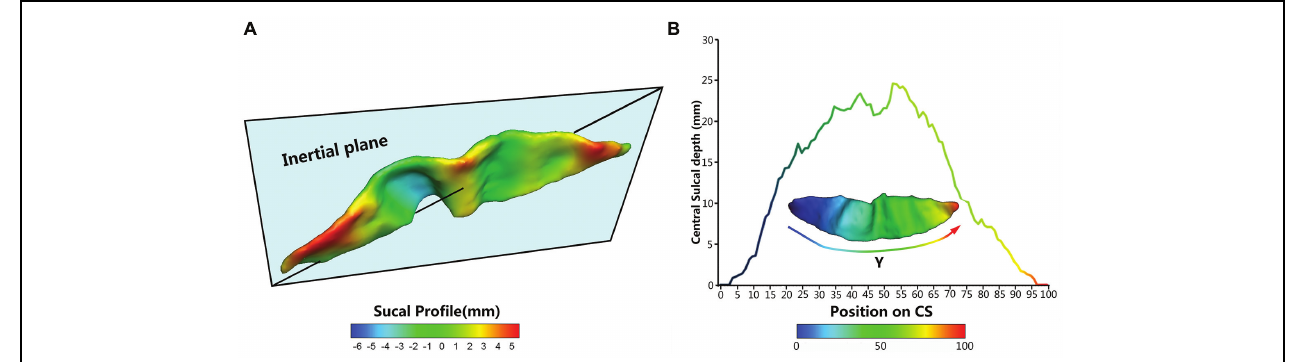
FIGURE 2 | The central sulcal profile and the Depth-Position Profile (DPP). (A) Central sulcal profile coded by different colors (from negative in blue to positive in red) which is defined the signed distance between each vertex on the CS surface and inertia plane. (B) A CS mesh with y